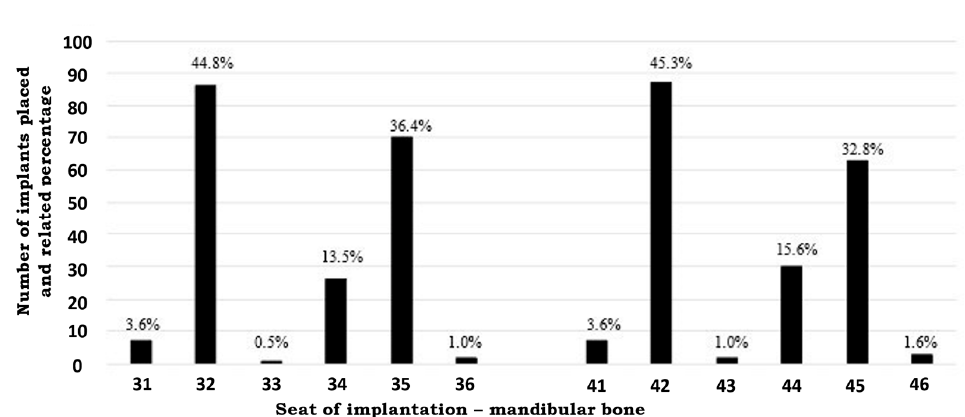
4 of 10 Table 1. Implants characteristics and torque values.